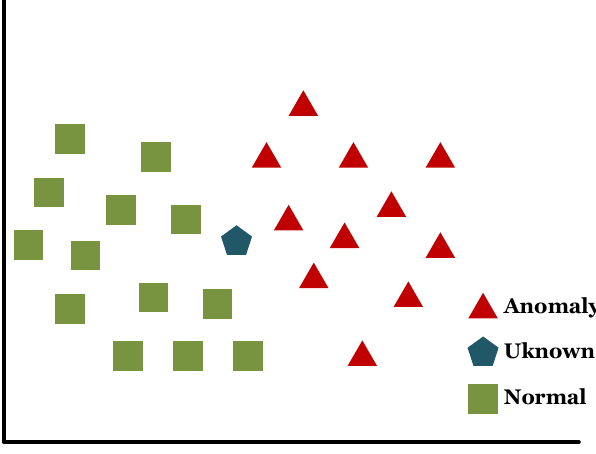
Figure 11. K-Nearest Neighbor (KNN) classification